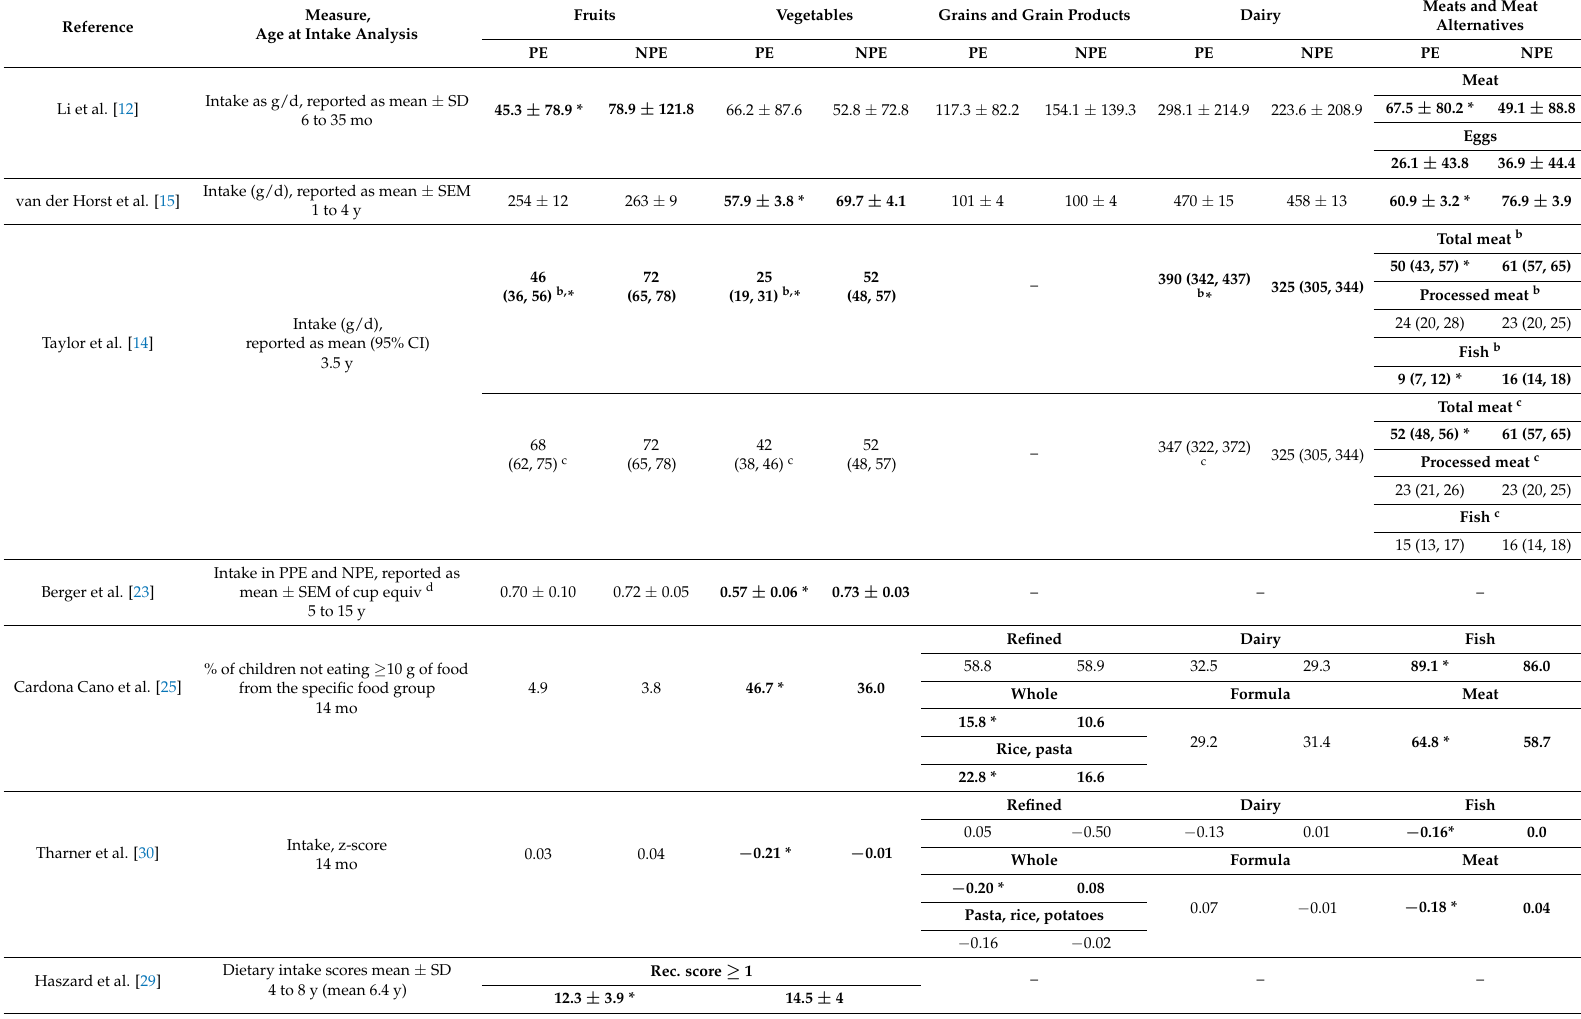
Table 2. Food Preferences Assessed as Intakes of Foods from Major Food Groups in PE and NPE a